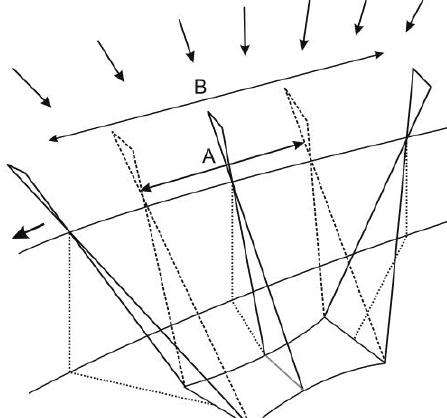
Figure 2. Asynchronous imaging mode with slow down factor B/A